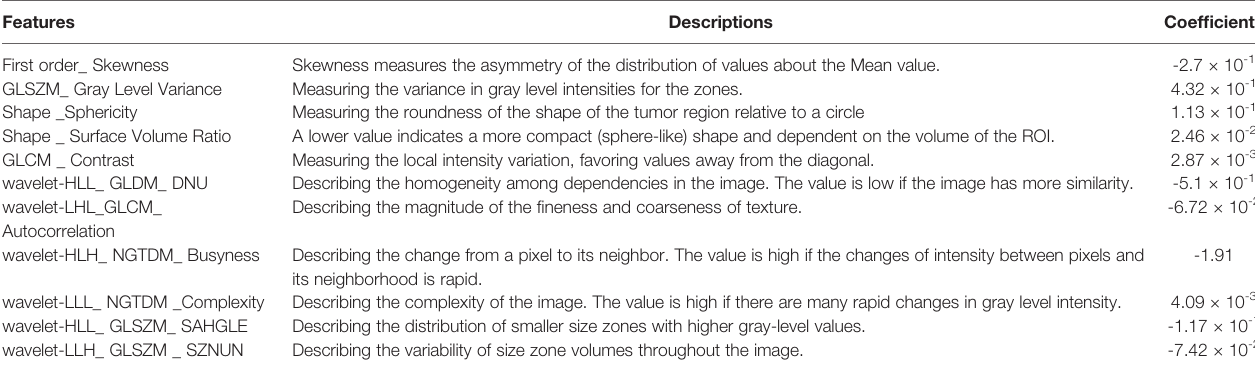
TABLE 2 | Eleven prognostic radiomics features selected by the LASSO algorithm. Features